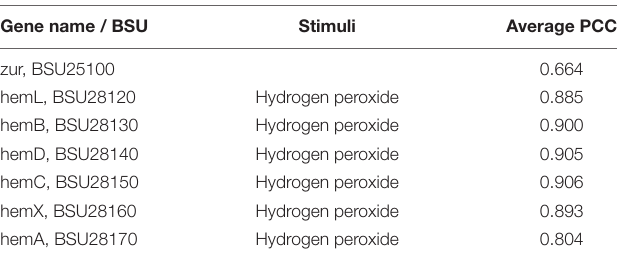
TABLE 5 | Atomic Regulon 56.